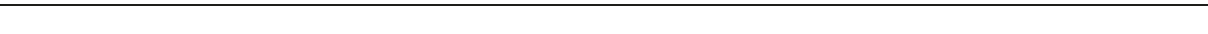
Fig. 4 In vivo angiogenesis from both the sinus venosus and endocardial cells is defective with Ino80 deletion. a – f Whole-mount confocal images ( a , d ) and quanti fi cation ( b , c , e , f ) of coronary vessel growth in indicated Ino80 -de fi cient hearts. a , b VE-cadherin immuno fl uorescence ( a ) and quanti fi cation of heart coverage ( b ) revealed that vessel growth on the dorsal side of the heart where the sinus venosus sprouts is signi fi cantly stunted. Images are representative of the following number of replicates: control, n = 4 hearts; mutant, n = 7 hearts at e15.5. Error bars in graphs are sd. (control, n = 8 hearts; mutant n = 6 hearts at e12.5, control, n = 4 hearts; mutant, n = 7 hearts at e15.5). **** P < 0.0001, evaluated by Student ’ s t -test. Scale bars: 100 μ m. c Vessel branching is also reduced in whole hearts. Error bars in graphs are sd. (control, n = 5 hearts; mutant, n = 6 hearts at e12.5, control, n = 4 hearts; mutant, n = 7 hearts at e15.5). *** P < 0.001, evaluated by Student ’ s t -test. d , e VEGFR2 immuno fl uorescence ( d ) and vessel coverage ( e ) shows a similar signi fi cant decrease on the ventral side of the heart where endocardial cell-derived coronary migration occurs. Images are representative of the following number of replicates: control, n = 6 hearts; mutant, n = 5 hearts at e15.5. Error bars in graphs are standard deviation. (control, n = 6 hearts; mutant, n = 5 hearts at e15.5). ** P < 0.01, evaluated by Student ’ s t -test. Scale bars: 100 um. f Endocardial-derived vessel branching is also stunted in whole hearts. Error bars in graphs are standard deviation. (control, n = 4 hearts; mutant, n = 6 hearts at e15.5). **** P < 0.0001, evaluated by Student ’ s t -test. Scale bars: 100 μ m. g , h Confocal images of the right lateral side of e15.5 hearts ( g ) and quanti fi cation ( h ) showed a dramatic decrease in SM-MHC + arterial smooth muscle (arrowheads) in mutant hearts. Error bars in graphs are standard deviation. Images are representative of the following number of replicates: control, n = 5 hearts; mutant, n = 6 hearts. Scale bars: 100 μ m. i , j Comparison of genes changed in e13.5 Tie2Cre;Ino80 fl / fl hearts with those reported to be speci fi cally expressed in either endocardial or coronary endothelial cells. Ino80 mutants are enriched in endocardial genes and depleted of coronary